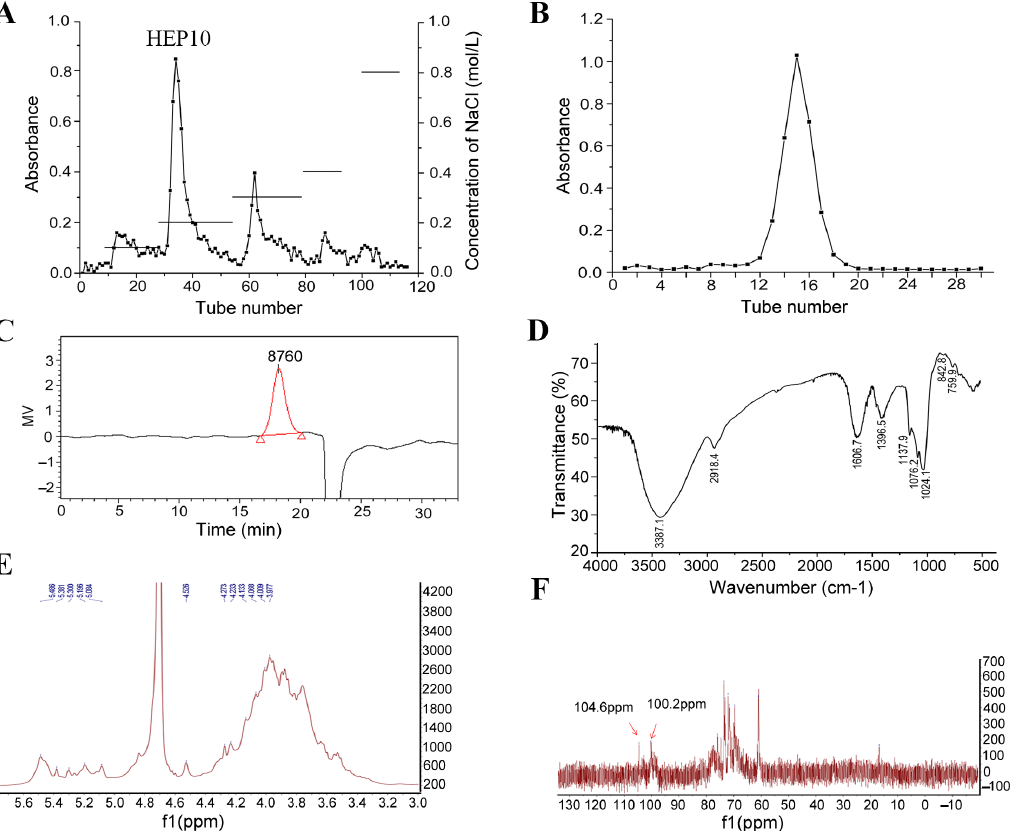
Figure 1. Structural characterization of HEP10. Chromatograms of HEP10 from ( A ) DEAE fast flow chromatography, ( B ) Superdex G-75 chromatography. ( C ) Molecular distribution of HEP10 by HPGPC. ( D ) FT-IR spectrum of HEP10. NMR spectra of HEP10: ( E ) 1 H NMR spectrum; ( F ) 13 C NMR